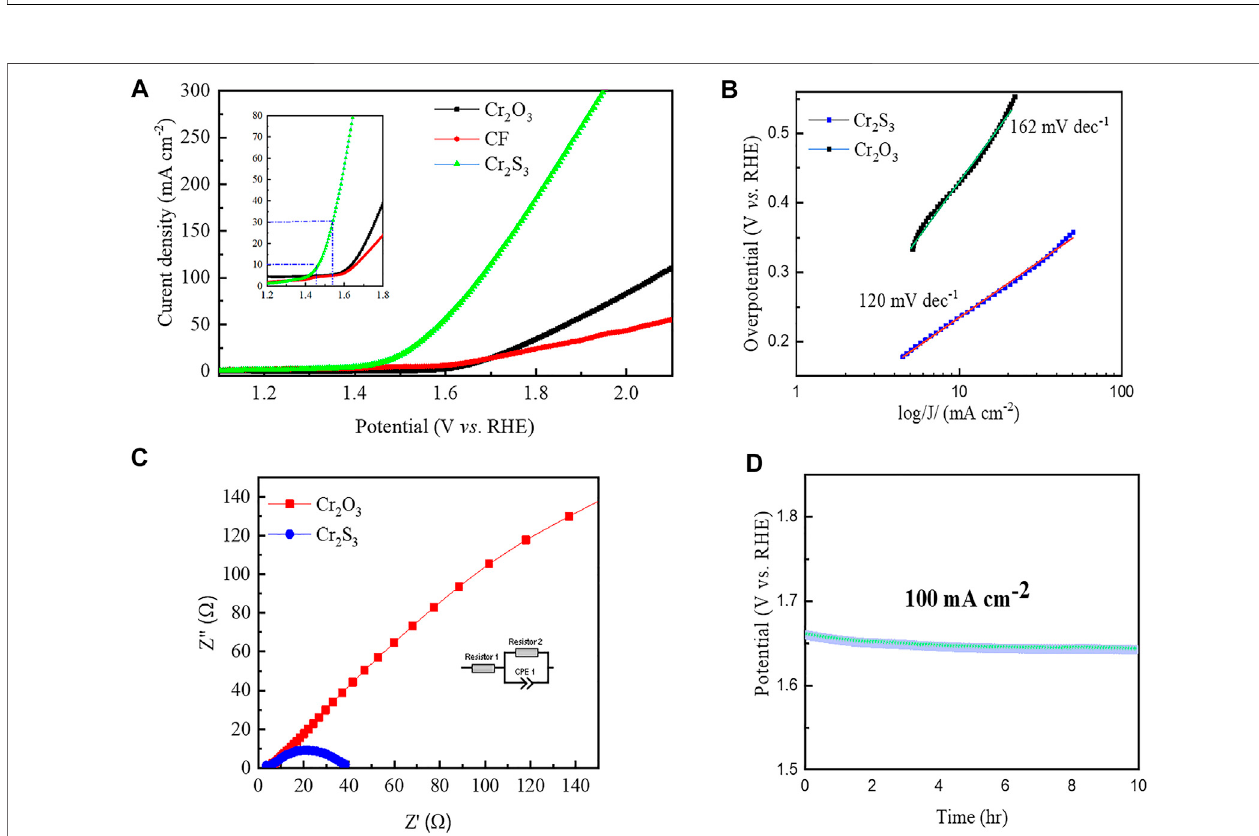
FIGURE 4 | Catalytic performance for the oxygen evolution reaction. (A) Anodic scan of linear sweep voltammetry curves (inset shows the magni fi ed plot for a maximumcurrentdensityof80 mAcm − 2 ). (B) Tafelplotextractedfromthelinearsweepvoltammetrycurves. (C) Nyquistplotsatanoverpotentialof300 mVwithaninset showing the equivalent circuit model. (D) Chronopotentiometry at 100 mAcm − 2 showing the durability test.